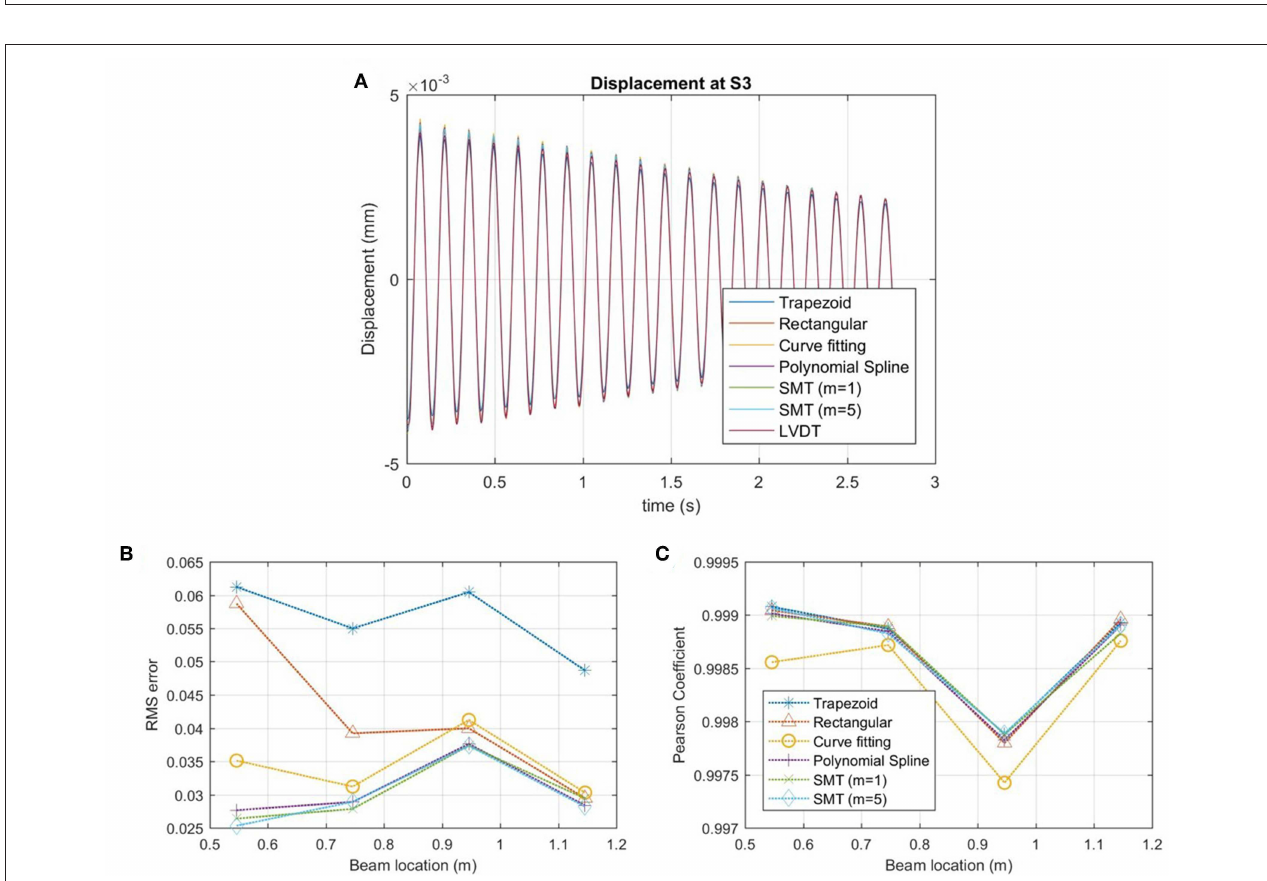
displacement calculated based on the strain. To evaluate the performance of these methods, the RMS error and the Pearson coefficient were calculated and are shown in Figures 8B,C . For the free vibration tests, the errors observed for the methods were similar in magnitude to the errors observed for the static tests with a maximum error < 6.5% and a minimum error of 2.5%. The trapezoid method had the highest RMS error and the curve